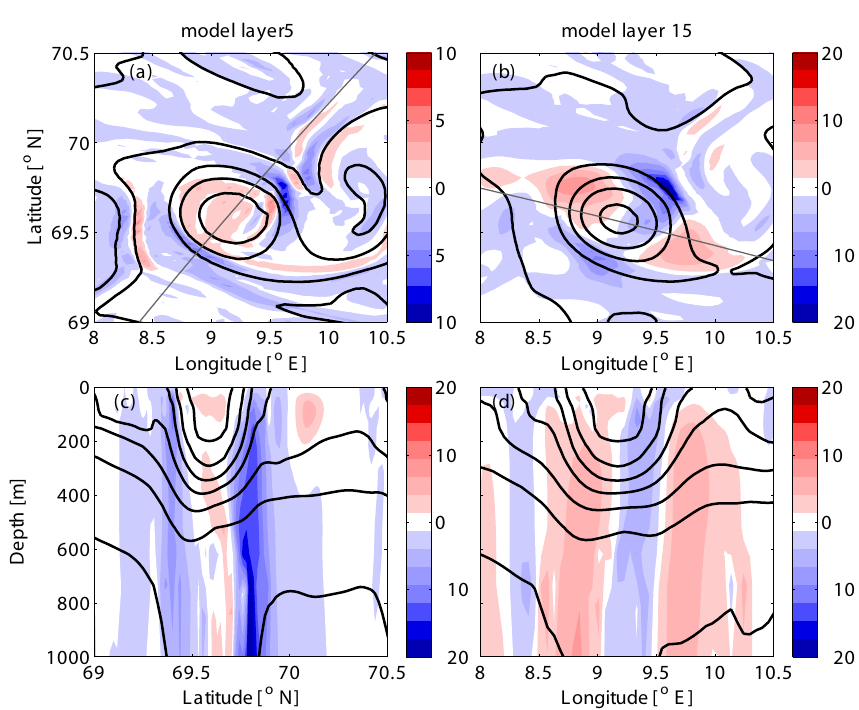
Fig. 3. The vertical velocity in the eddy, close to the surface in layer 5 (16–21m) (a) , and further down in layer 15 (152–178m) (b) . Two cross-sections of the vertical velocity in the eddy are shown ( c and d ), the location of each cross-section is shown with a gray thin line in the panel above. The thick black lines are isopycnals. The vertical velocity and density are 5-day averages from the period 19–23 March 1999.